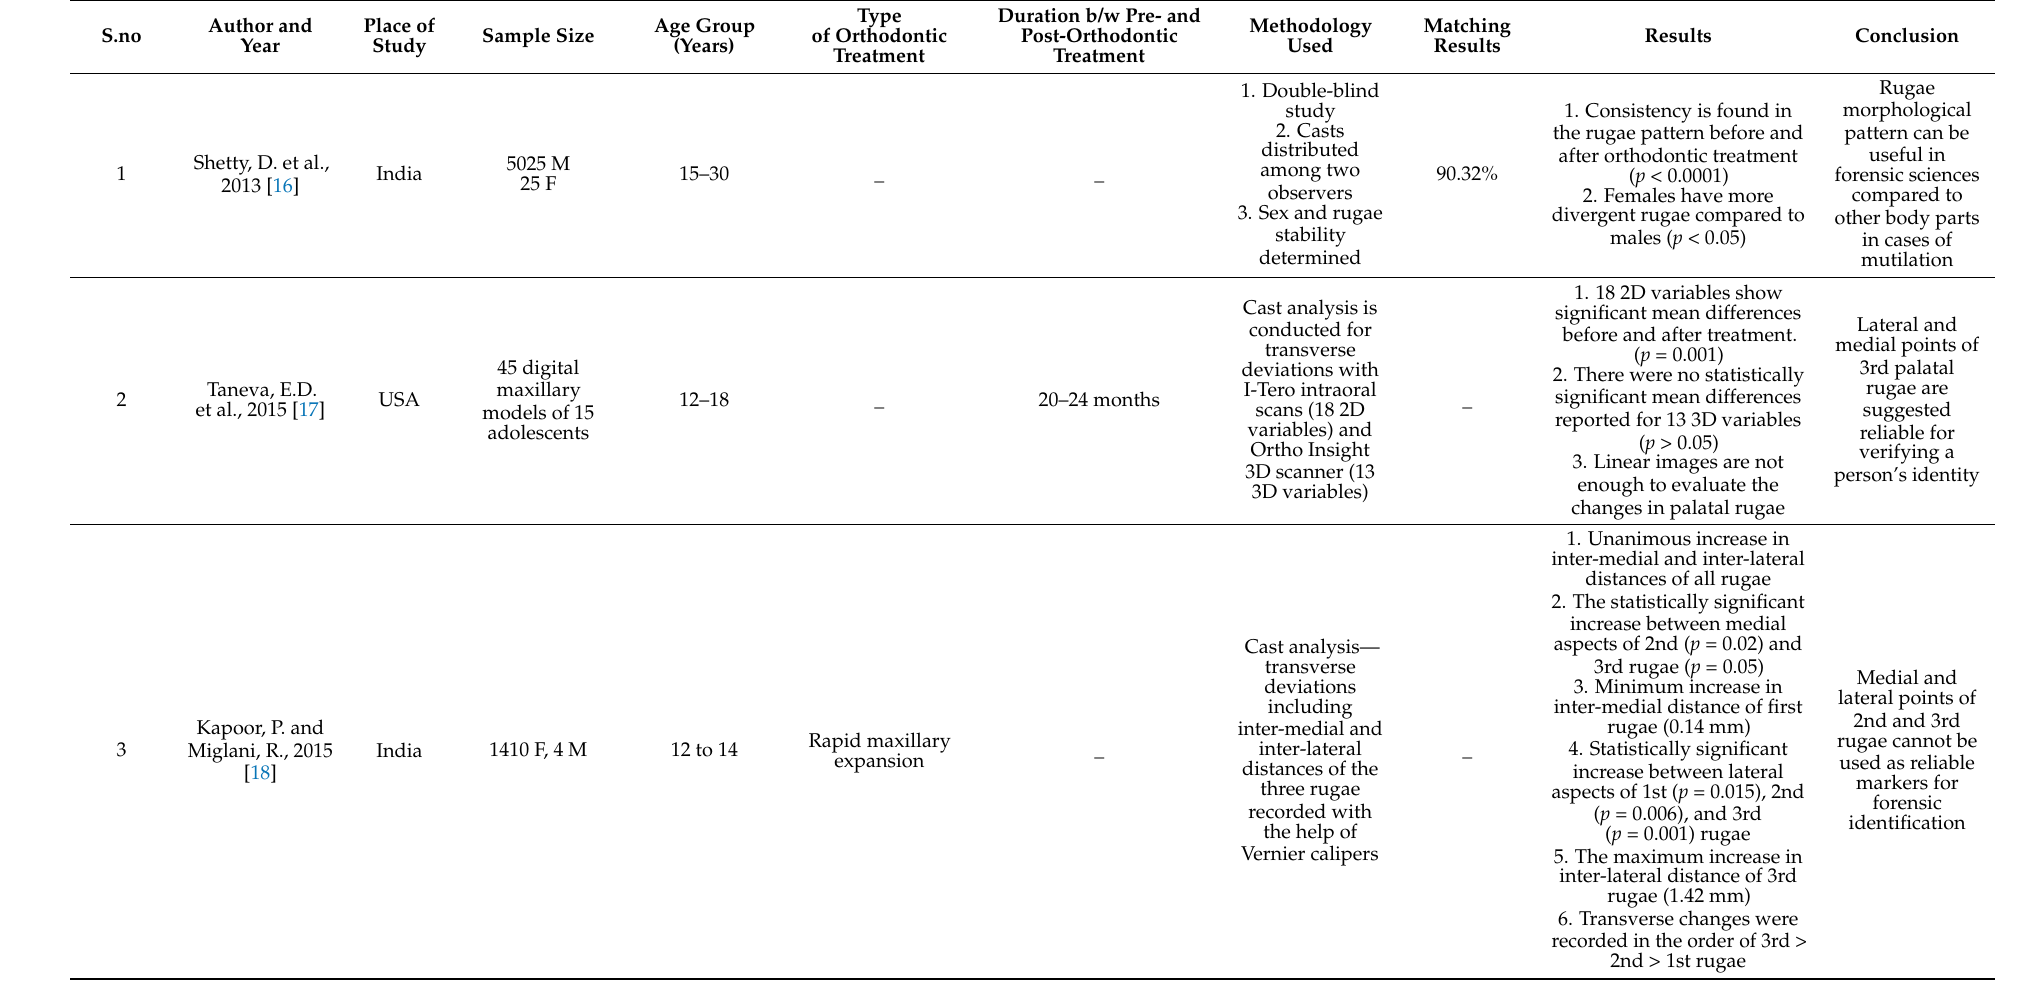
Table 1. Summary of the data extracted from the included